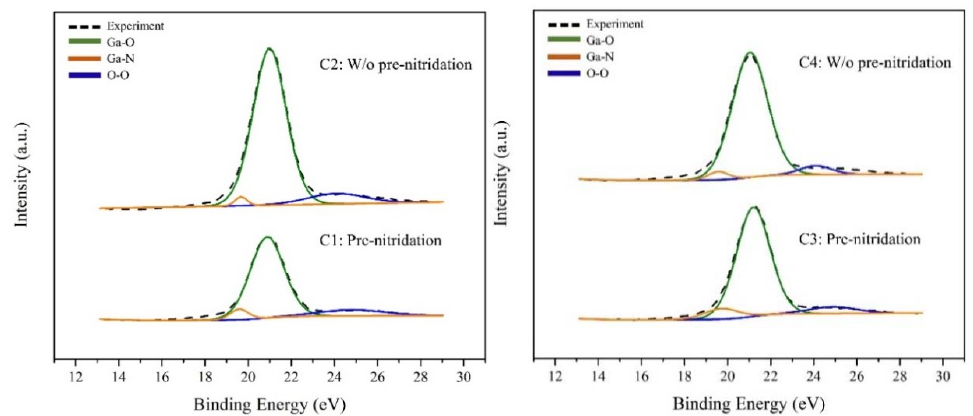
Figure 4. De ‐ convoluted Ga ‐ 3d X ‐ ray photoelectron spectroscopy (XPS) spectra of GaN nanodots on Si (111) for samples C1, C2, C3, and C4.